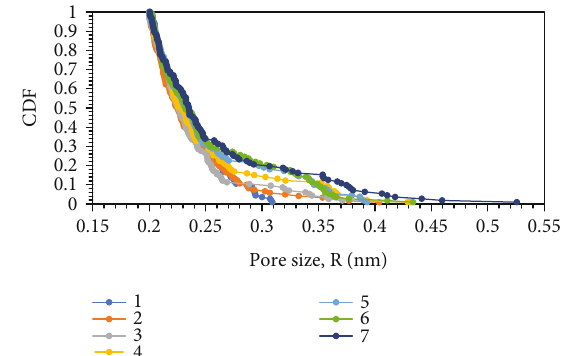
Figure 5: Cumulative distribution function of the PSD for the seven con fi gurations.